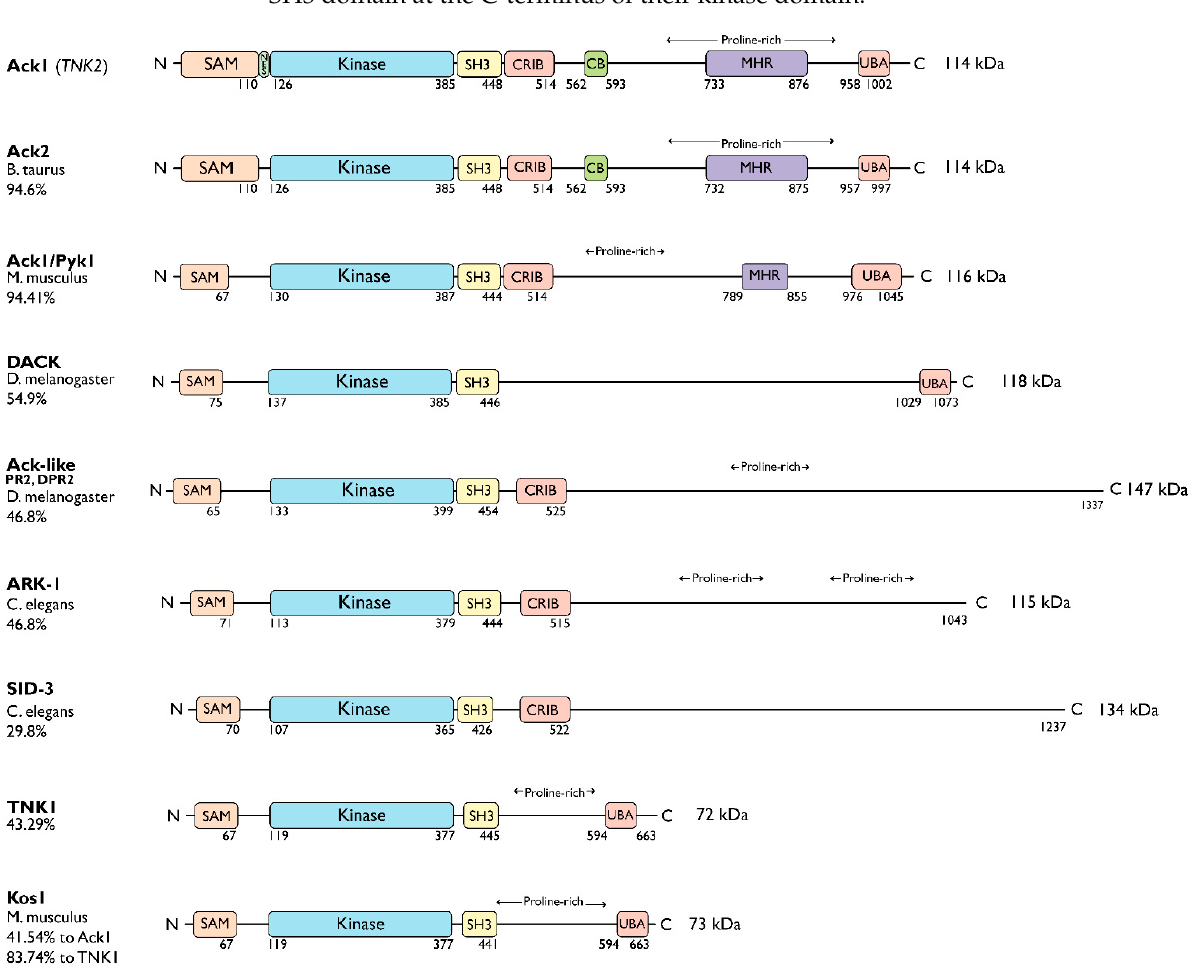
Figure 1. Ack family kinases. Linear representation of Ack family members. The residue numbers below each domain depict the boundaries of the domains retrieved from the UniProtKB [10]. SAM, sterile alpha motif; NES, nuclear export signal; CRIB, Cdc42, and Rac-interactive binding (CRIB) domain; CB, clathrin-binding motif; proline-rich region; MHR, Mig6 homology region; UBA, ubiquitin-associated domain. The sequence identity between each member and human Ack1 (or TNK1) is indicated to the left of the linear diagram as percentage identity. UniProtKB IDs